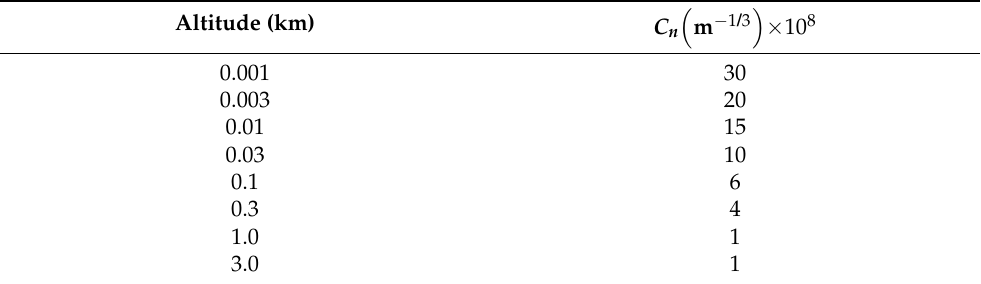
Figure 18. Height-based refractive index structure coefficient: Fried’s, Brookner’s, Tatarski’s, and Hufnagel’s models [74]. Table 11. Refractive index structure coefficient as a function of height (typical values) adapted from